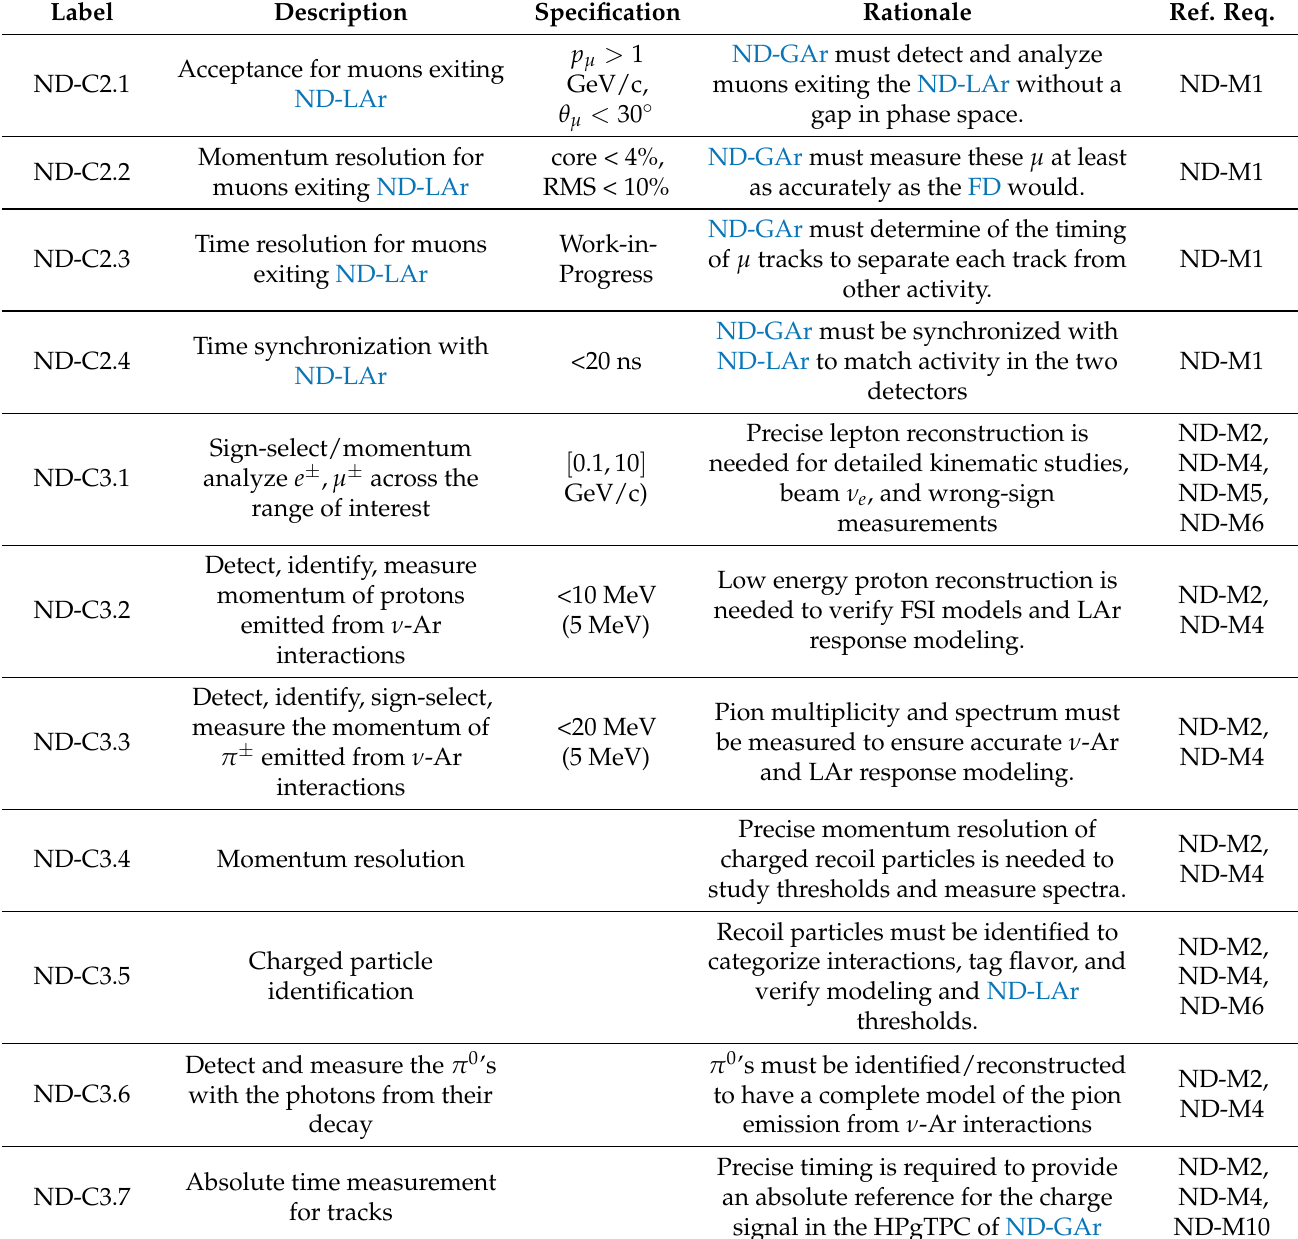
Table 6. Capability requirements for